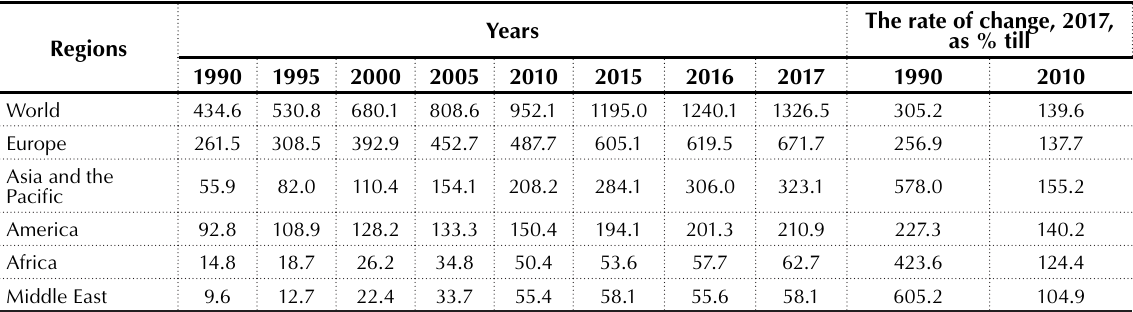
Table 1. International tourist arrivals, 1990–2017 (million) Source: Build by the authors based on the materials from Tourism Highlights